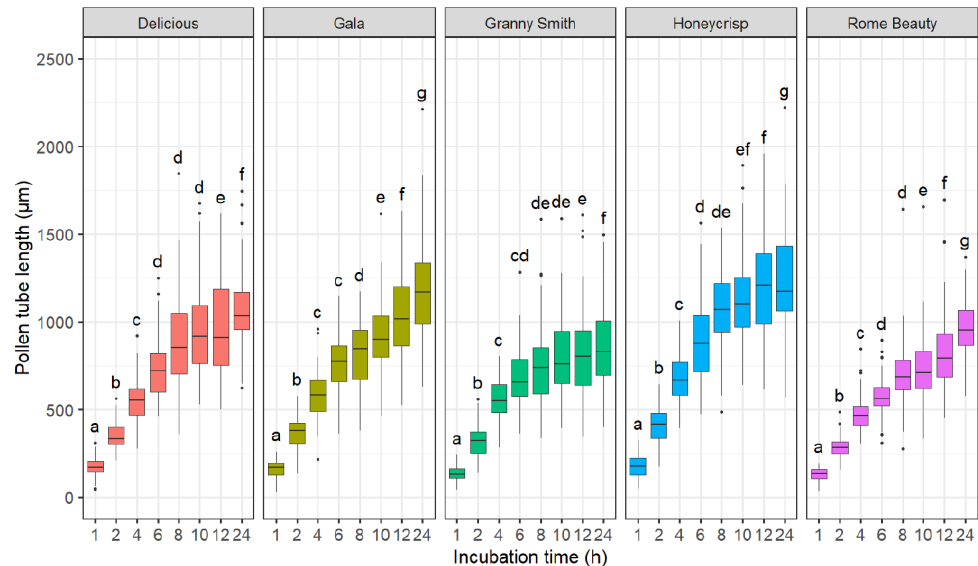
Figure 1. Effect of incubation time on in vitro pollen tube length of ‘Delicious’, ‘Gala’, ‘Granny Smith’, ‘Honeycrisp’, and ‘Rome Beauty’. Different letters indicate significant differences among incubation times within cultivars based on Games-Howell test ( p < 0.05).